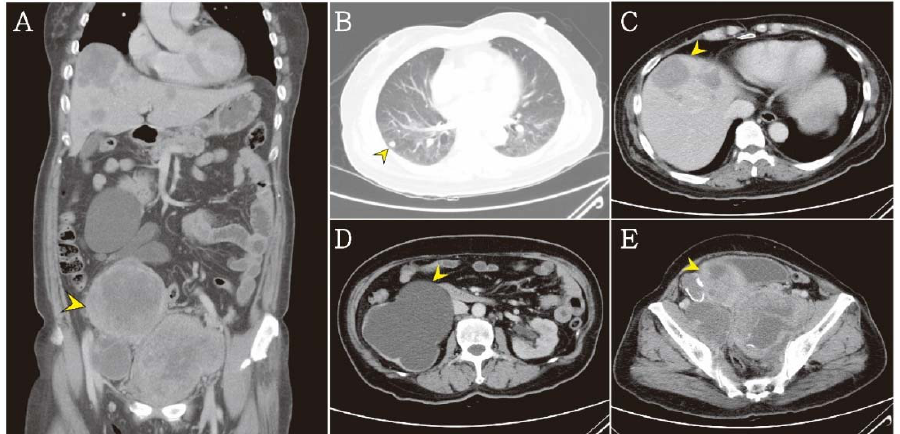
Figure 3. ( A ) The abdominal computed tomography revealed a huge heterogeneous density mass (arrow head). ( B ) Multiple pulmonary nodules were noted in lung field (arrow head). ( C ) Multiple heterogeneous hepatic tumors were noted (arrow head). ( D ) Severe hydronephrosis at right kidney were noted due to tumor compression (arrow head). ( E ) Three parts of heterogeneous pelvic tumors were noted about 9.4 × 8.6 × 9.3 cm 3 , 7.1 × 6.1 × 6.0 cm 3 , 11.1 × 7.5 × 9.1 cm 3 (arrow head).